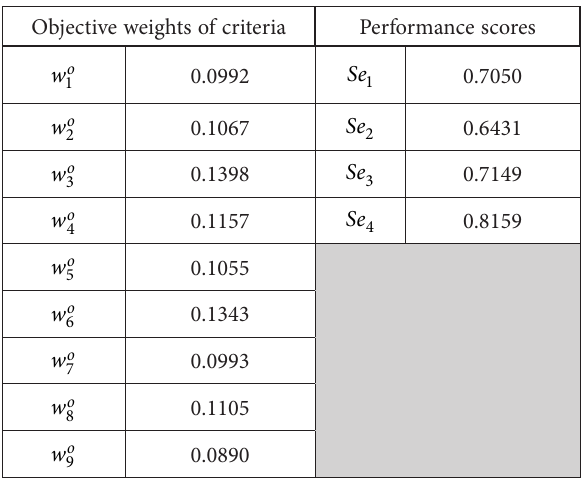
Table 5. The results of solving the SECA model Objective weights of criteria